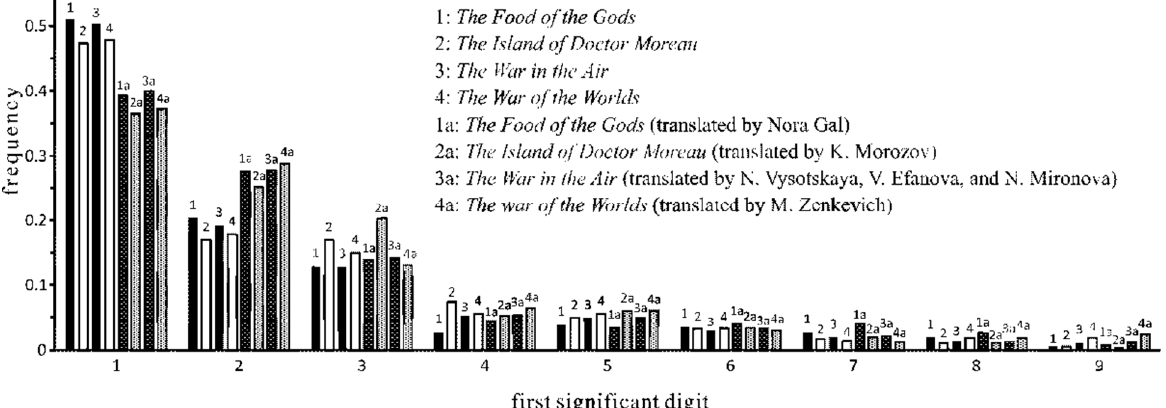
Figure 10. Distribution of the first significant digits of numerals in H. G. Wells’ novels and in their Russian translations.